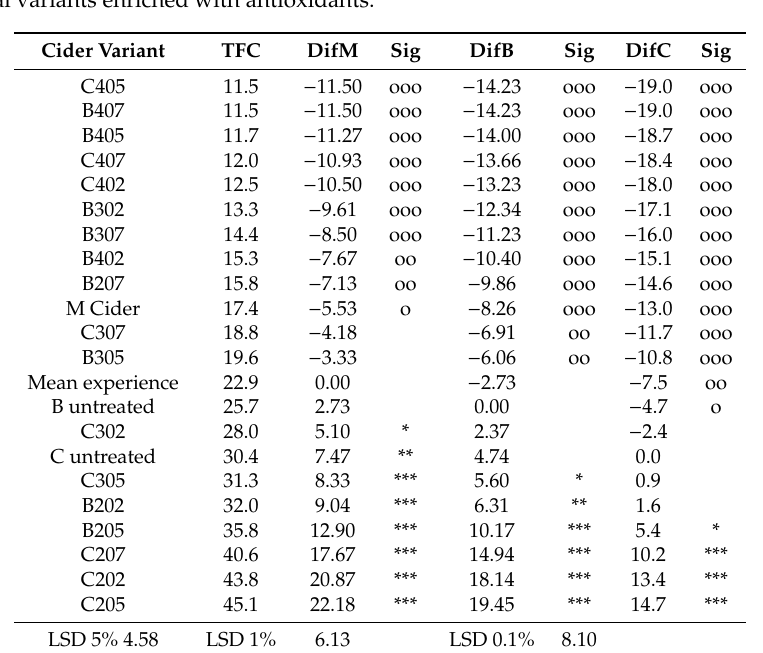
Table 5. Influences of the treatments and extracts addition on total flavonoids content of the cider experimental variants enriched with